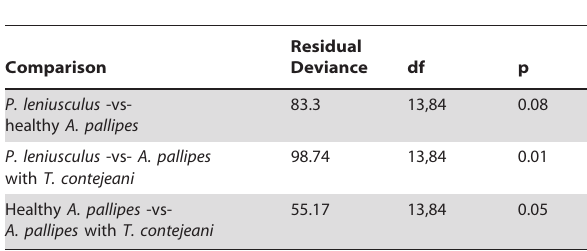
Table 5. Pairwise generalised linear model comparisons between crayfish groups in overall shape of functional response.